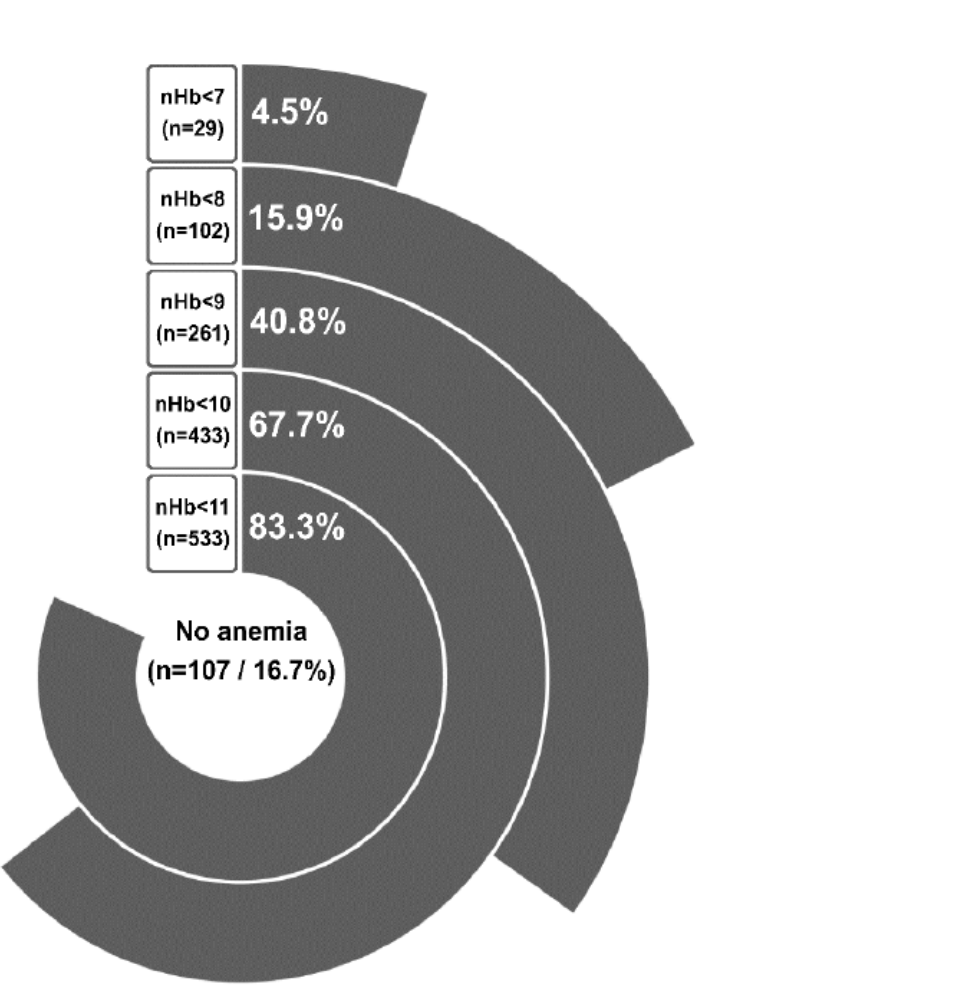
Figure 1. All patients in the cohort are represented based on the nadir Hb (nHb) level. For every anemia subgroup the number of patients and percentage of the total population are depicted, re- spectively.